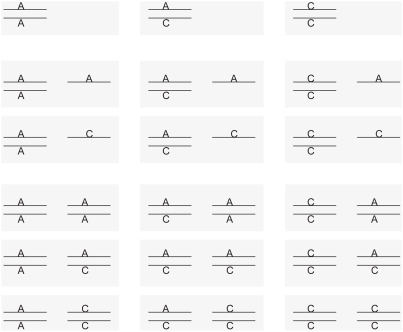
Possible cases of a SNP in a biallelic CNV.All possible cases of observed SNPs on a biallelic, duplication-type CNV. Each gray box represents an individual. Two parallel lines are homologous chromosomes. The left homologous pair represents the original site (L1) and the right pair represents the ectopic site (L2). The ectopic site may not exist or exist in only one of the homologous chromosomes in some individuals.